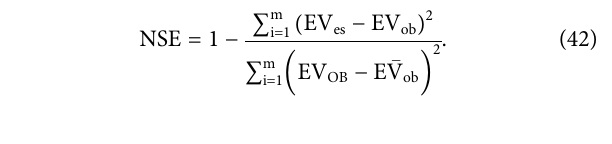
TABLE 3 | The optimum input variations for various